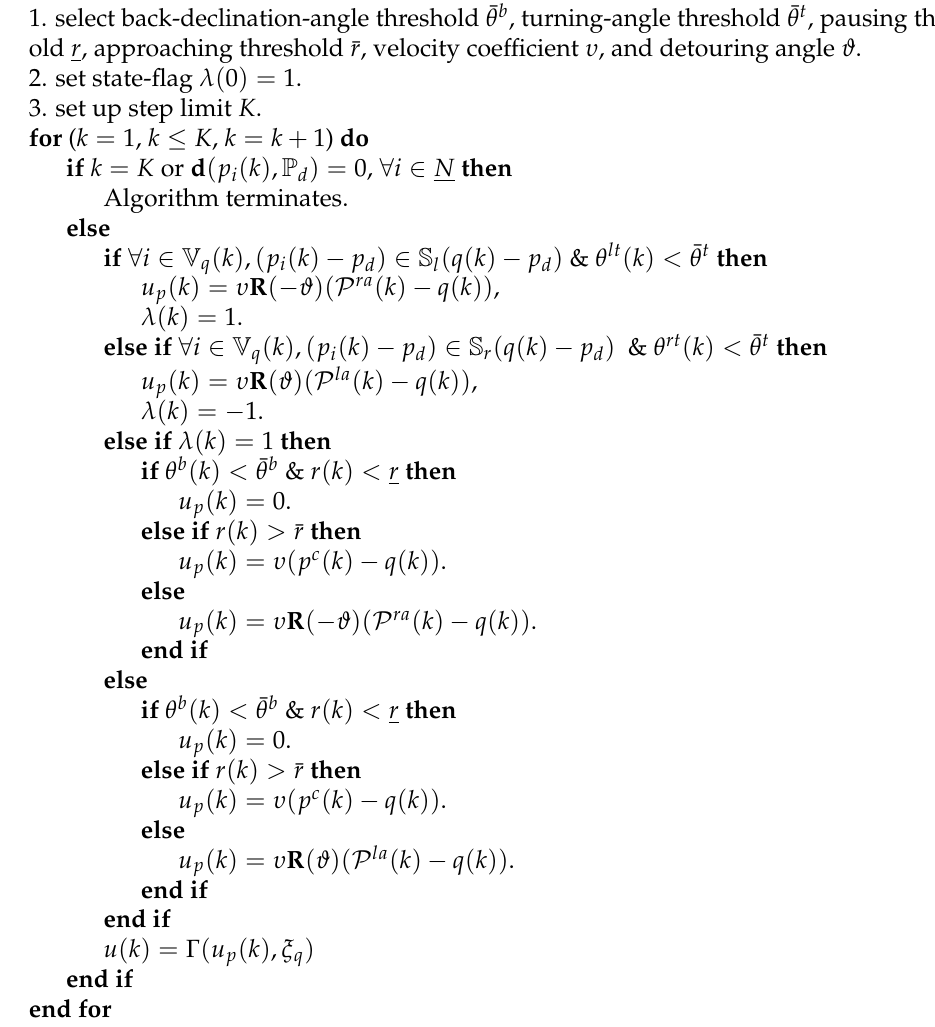
Algorithm 3 Herding Algorithm With Pausing